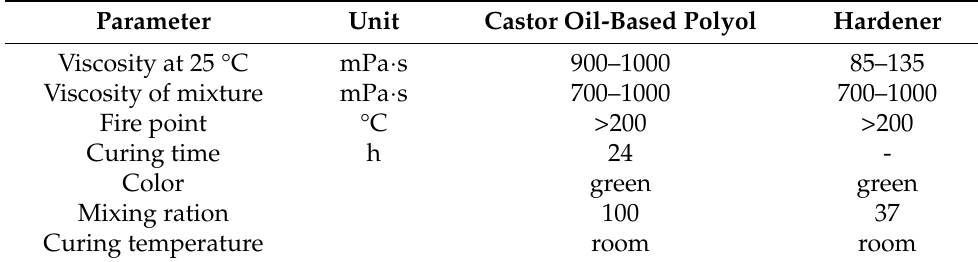
Table 1. Technical parameters of main base and hardener [38].